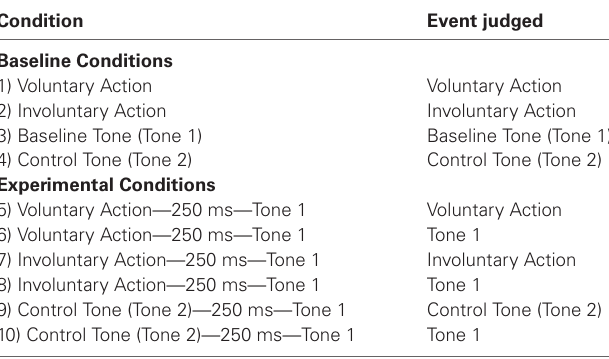
Table 1 | Conditions (Baseline and Experimental) and event judged by the participants in each condition . Condition